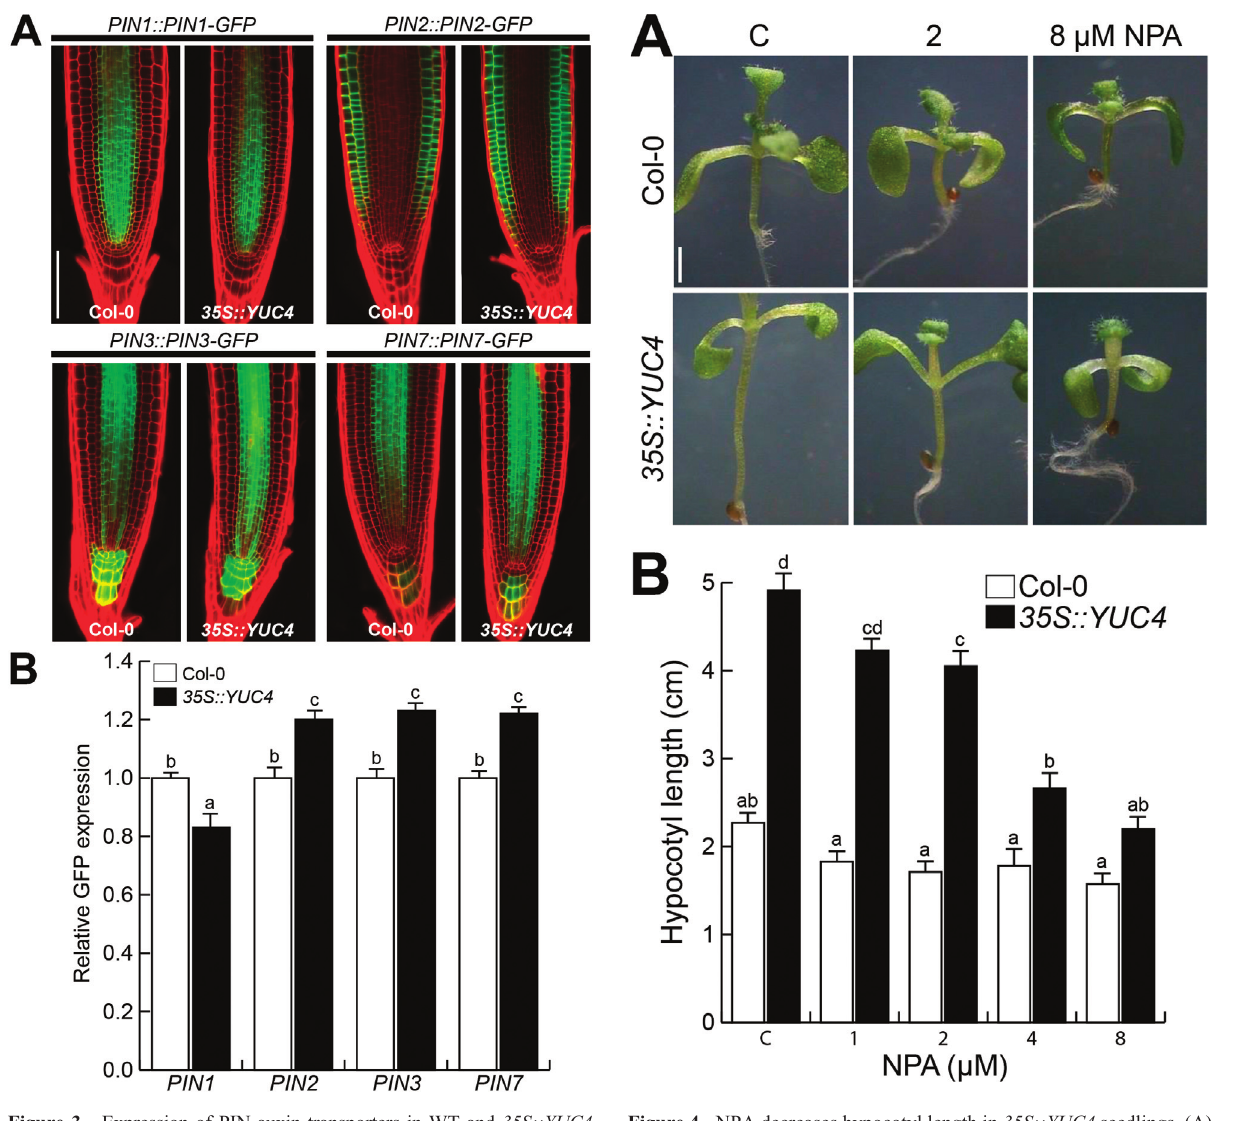
Figure 3 - Expression of PIN auxin transporters in WT and 35S::YUC4 seedlings. (A) Confocal microscopy images of WT and 35S::YUC4 seed- lings showing PIN1::PIN1-GFP , PIN2::PIN2-GFP , PIN3::PIN3-GFP and PIN7::PIN-GFP fluorescence.Bar=100 (cid:2) M.(B)Quantificationofrelative GFP expression of PIN transporters in WT and 35S::YUC4 backgrounds. Plants were grown on MS 0.2X and analyzed at 10 d. Bars in graphics indi- cate standard error and different letters indicate statistical differences at P = 0.05 . The analysis was repeated three times with similar results.